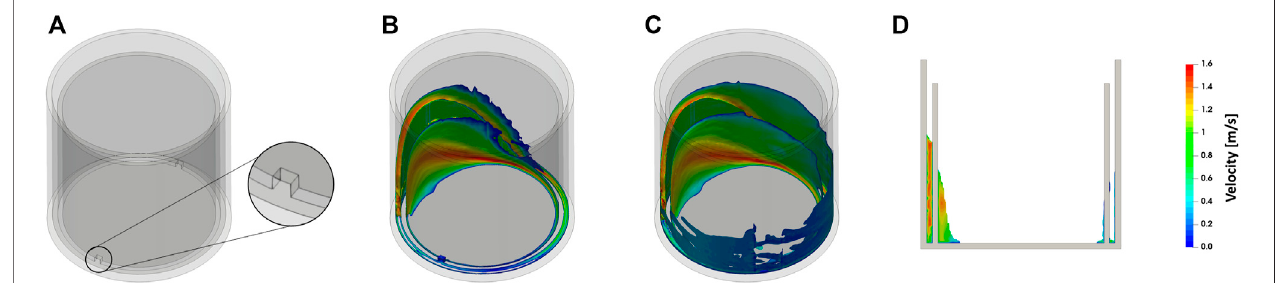
FIGURE 1 | Design and working principle of the perforated ring fl ask. (A) Illustration of an empty perforated ring fl ask. (B) Illustration of the bulk liquid within a perforated ring fl ask. (C) Illustration of the bulk liquid and the liquid fi lm within a perforated ring fl ask. (D) Side view of a perforated ring fl ask with liquid. The images are createdbasedonaCFDsimulationasdescribedinthe MaterialsandMethods section.Simulationconditions:innervesseldiameterd i =80 mm,innerringdiameterd ring,i = 70.6 mm, ring wall thickness d wall = 2.2 mm, and 2 perforations with 3 mm × 3 mm size; fi lling volume V L = 10 ml; shaking diameter d 0 = 50 mm; shaking frequency n = 300